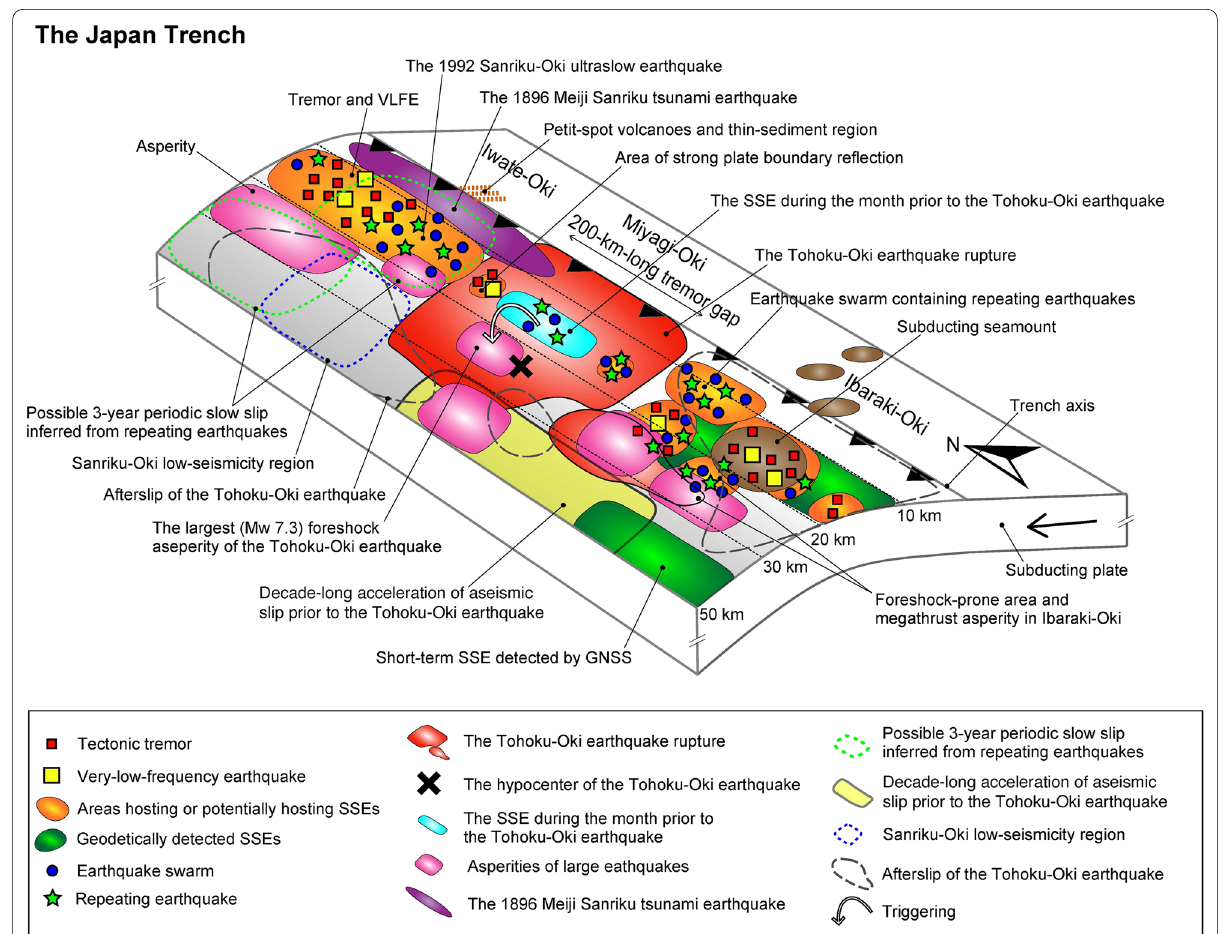
Fig. 14 Schematic of the interplate slip behavior of the Japan Trench. For an explanation of the symbols, refer to the legend in the